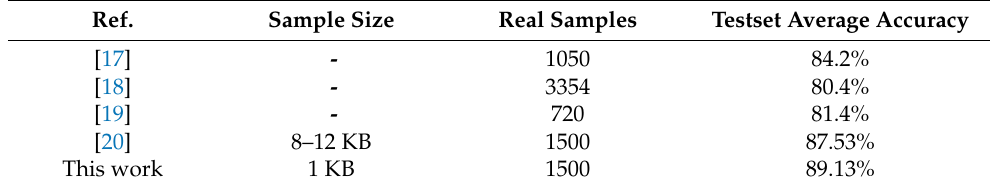
Table 5. Comparison with other